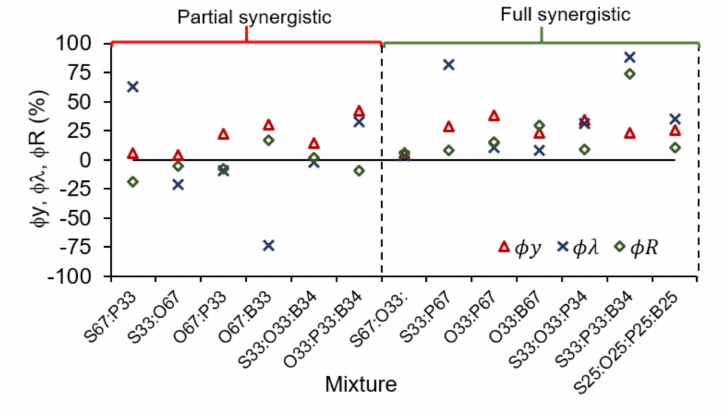
Figure 5. Synergistic effects of AcoD of slaughterhouse wastewater streams and bovine manure. The left side represents the mixtures that presented an antagonistic effect, while the right side indicates the mixtures with synergy in all the parameters ( φ y > 0; φλ and φ R > 0). The letter represents the waste stream (S: slaughter wastewater; O: offal wastewater; P: paunch wastewater; B: bovine manure) and the number its %VS in the